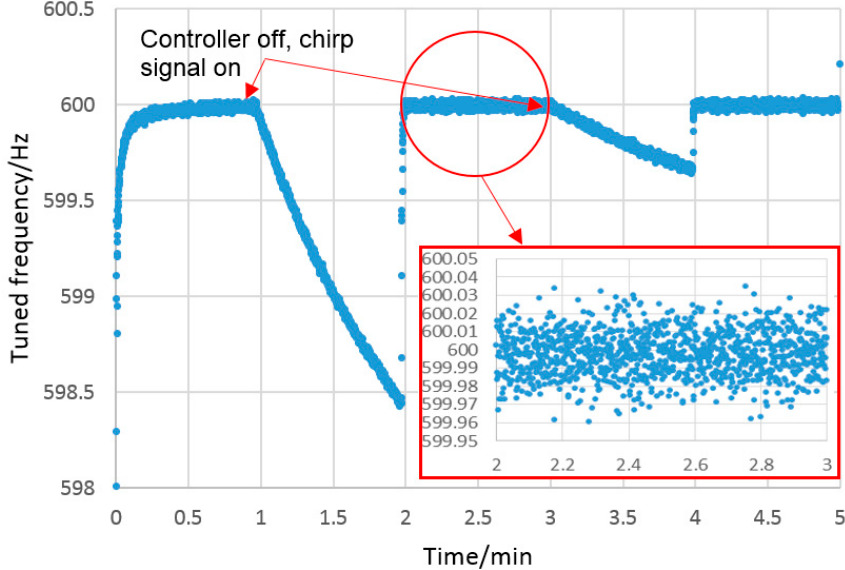
Figure 12. Frequency plot illustrating how actuator drift reduces following a series of actuator load cycles.